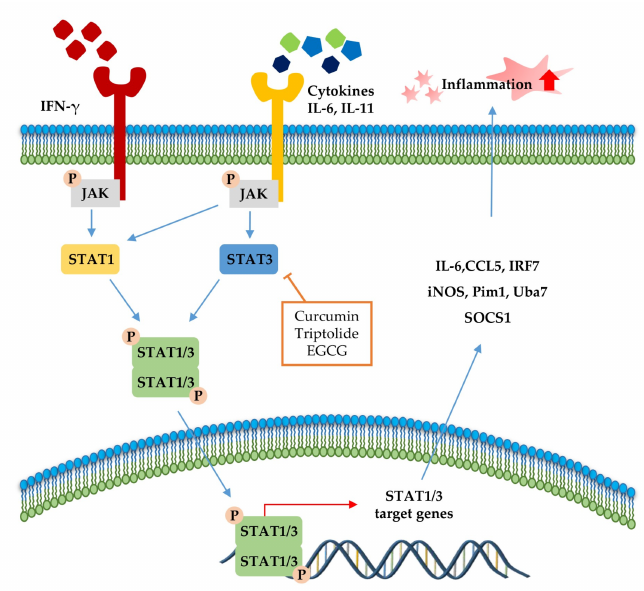
Figure 3. Signal transducer and activator of transcription (STAT)1 and STAT3 pathways in the inflammatory response. STAT signaling is activated by cytokines (IL-6, IL-11, and IFN- γ ). Canonically, ligand binding to receptors triggers Janus kinase (JAK) phosphorylation and, subsequently, STATs, followed by STAT dimerization. The dimers translocate to the nucleus, where it drives transcription of target genes involved in inflammation. The signaling steps that are a ff ected by phytochemicals in the STAT1 / 3 pathway axis are